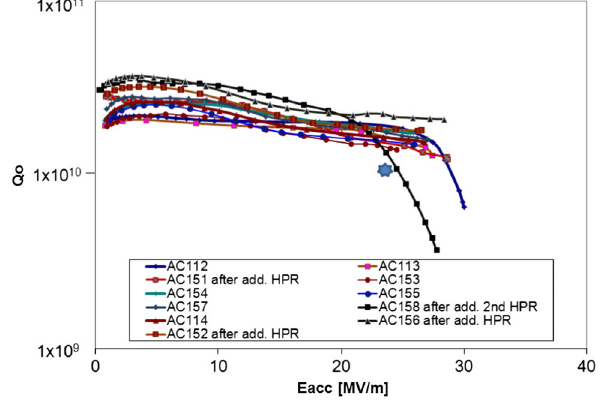
FIG. 12. Q 0 ð E acc Þ of the LG cavities AC112–AC114, AC151– AC158 at 2 K after BCP. Test after prior 100 (cid:4) m BCP, annealing at 800 (cid:2) C for 2 h, final BCP of 20 (cid:4) m , and baking at 130 (cid:2) C for 48 h. The star shows the XFEL requirements. AC112 was not baked; AC113 and AC114 are baked after additional 20 (cid:4) m BCP; AC158 demonstrated after 2nd HPR still field